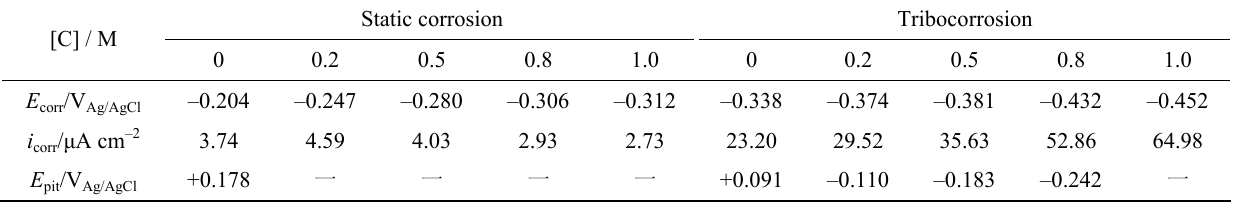
Table 2 Corrosion parameters for NAB alloy in seawater as a function of halide ions concentration. Static